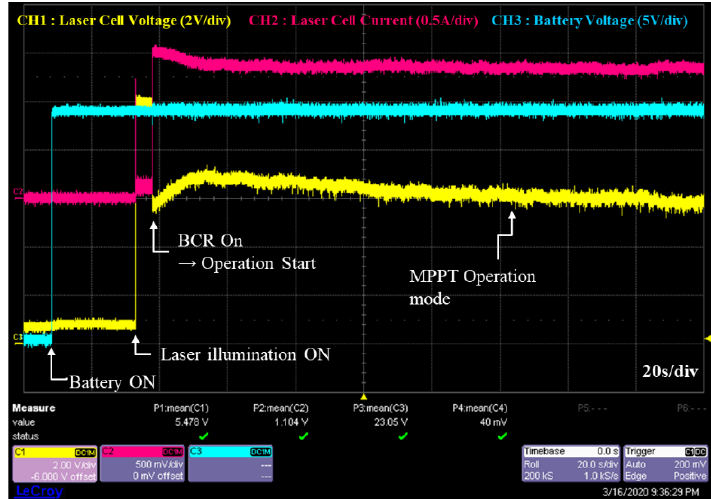
Figure 20. Experimental result of maximum power point tracking (MPPT) control of laser PV module for battery charging.